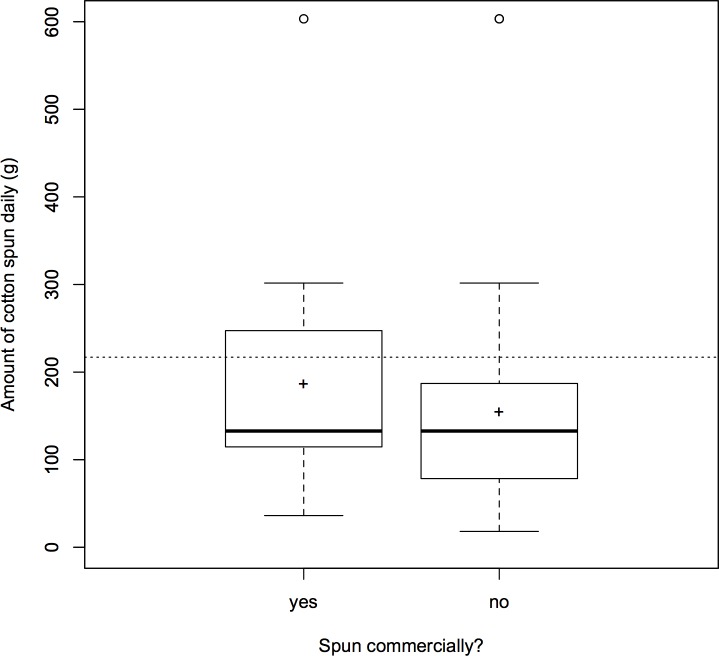
Amount of cotton spun daily by Chinese girls born 1907–1943 (n = 137), subdivided by whether they spun commercially, which was significant (multiple regression: p = 0.002) when other covariates were considered (model C1).Boxes indicate the interquartile range (IQR), and whiskers extend to the farthest point ≤ 1.5 times the IQR. Individual points beyond the whiskers are plotted as circles. Medians are marked by the horizontal bar, and means by “+”, for direct comparison with average spinning rates Thomas Jefferson reported for enslaved girls at his Monticello and Poplar Forest plantations, indicated by the dotted line [35–37].